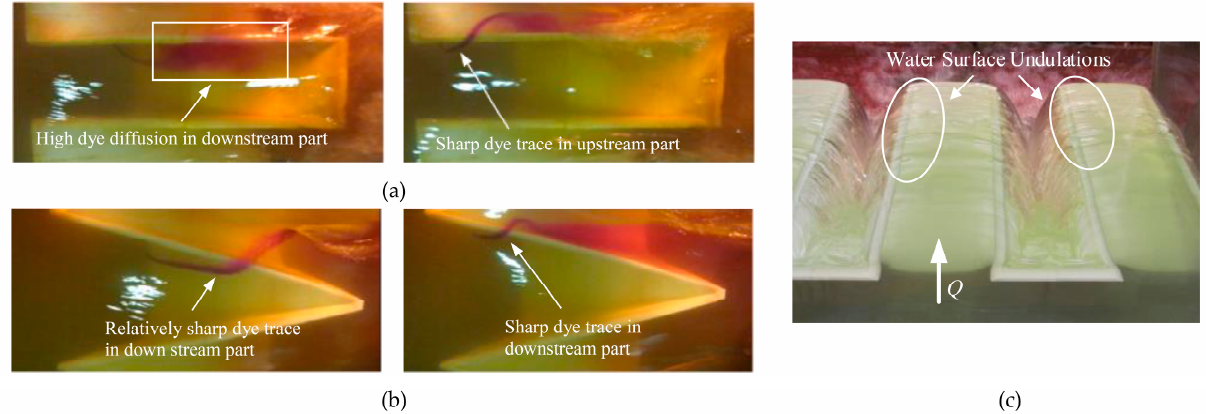
Figure 10. Experimental observations: ( a ) dye trace in Rec-B2 ( H o / P = 0.65, left-to-right flow direction); ( b ) dye trace in Tri-B2 ( H o / P = 0.65); ( c ) water surface undulations in Rec-B3 ( H o / P = 0.147).